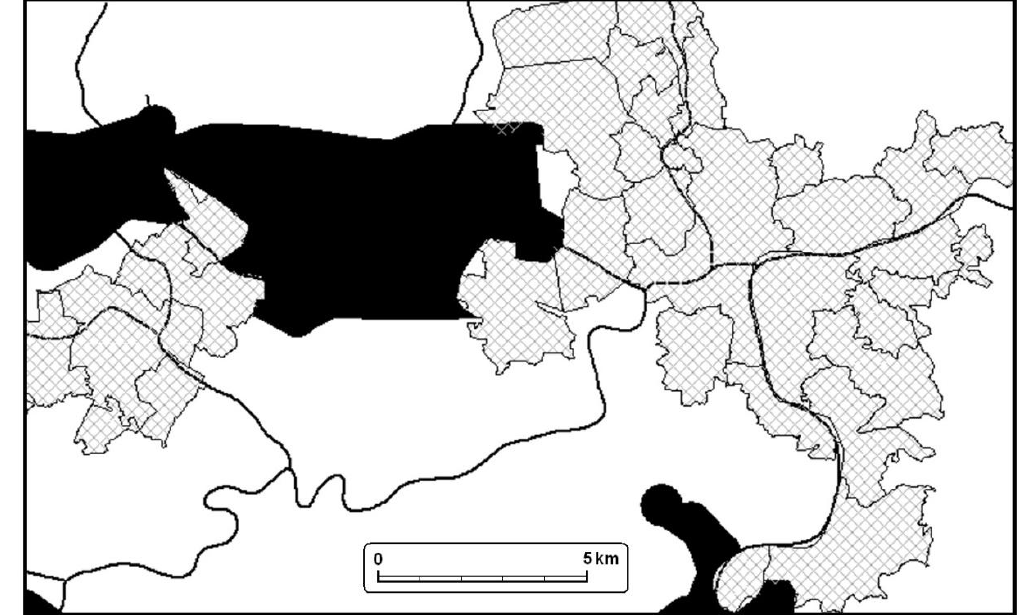
Fig. 5. Example of rounding contours of identified areas of post-industrial landscapes larger than 5 km 2 (Data sources: CENIA, Czech Geological Survey, CORINE LC 2006, CzechInvest, ČÚZaK, ČSÚ)